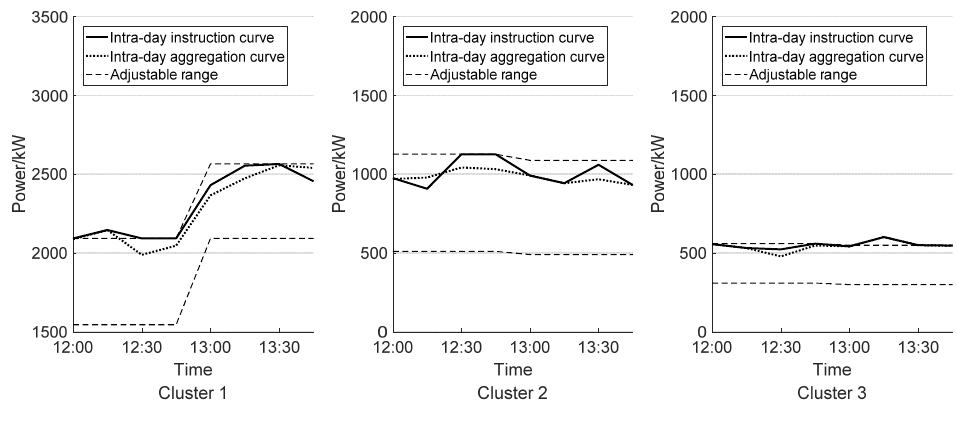
Figure 11. Intra ‐ day instruction curve of each cluster. Figure 11. Intra-day instruction curve of each